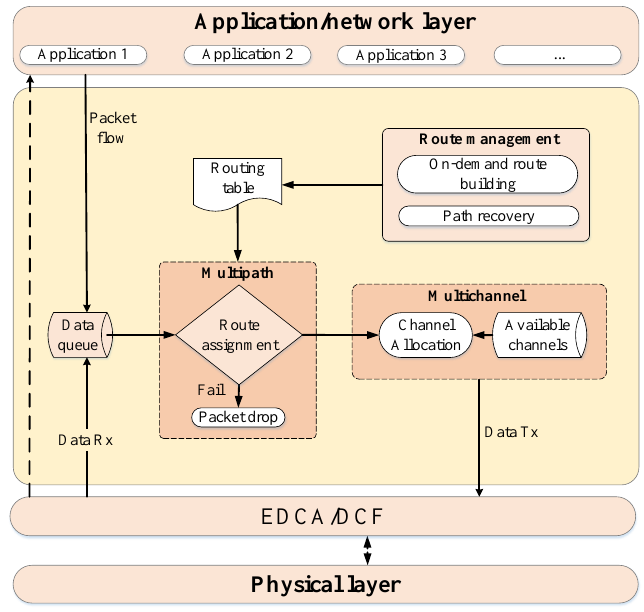
Figure 1. General view of the multi-path and multi-channel modules inclusion in